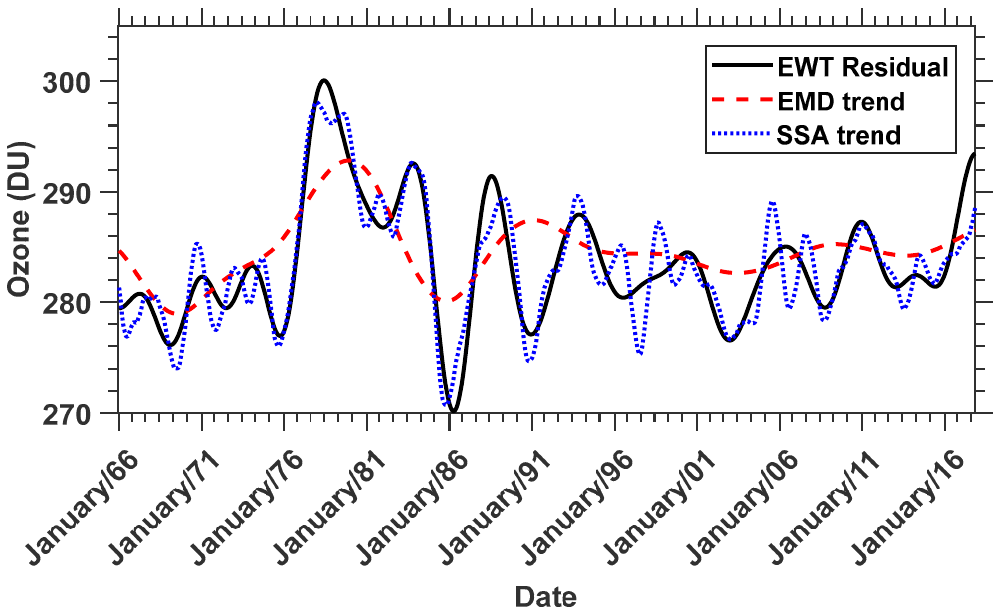
Figure 7. OCBA TCO trend time series extracted by (EWT) (black line), EMD (red dashed line), and singular spectrum analysis (SSA) (blue dotted line).